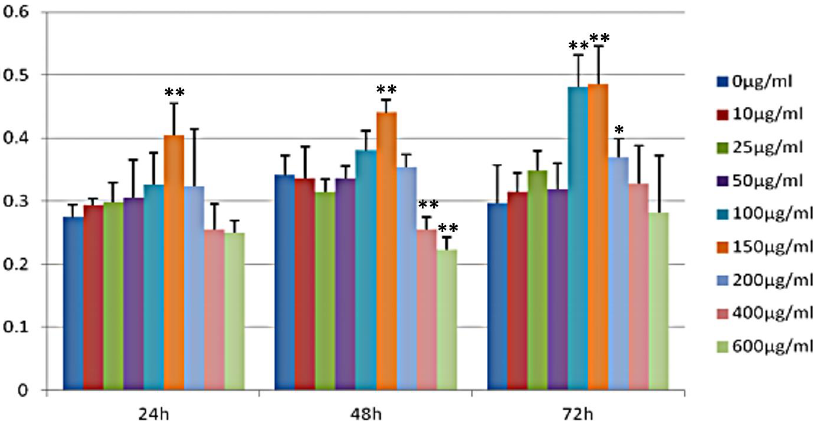
Figure 3. Effects of different GSP groups on proliferation of 3T3-L1 adipocytes. Values of the same time group, “*” means significant difference with control group ( p < 0.05), “**” means ( p < 0 . 01).